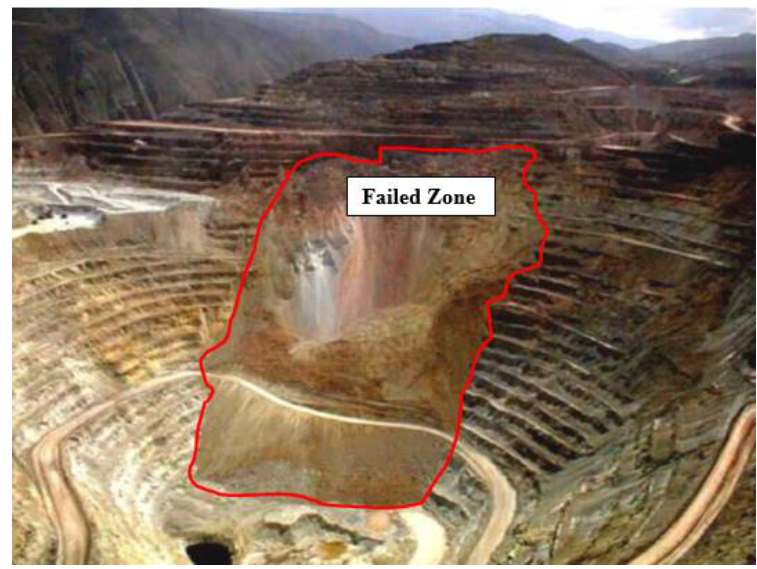
Figure 15. A large scale image of some portion of Chiquicamata slope (Adapted from [1]).